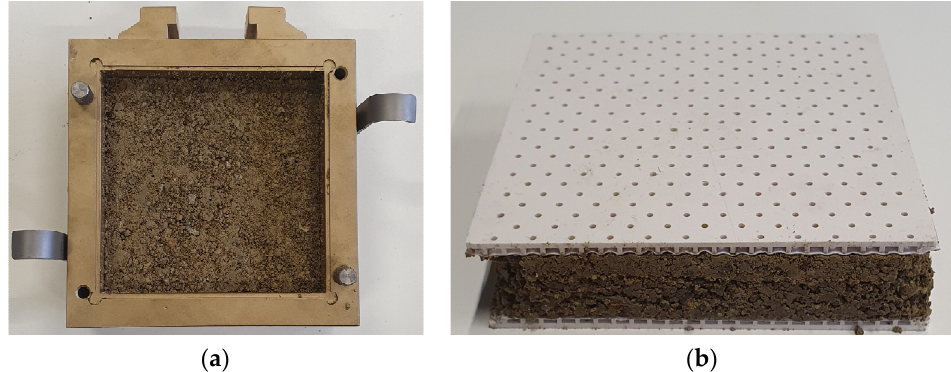
Figure 7. M5 specimen ( a ) before and ( b ) after the test conducted using direct shear device.